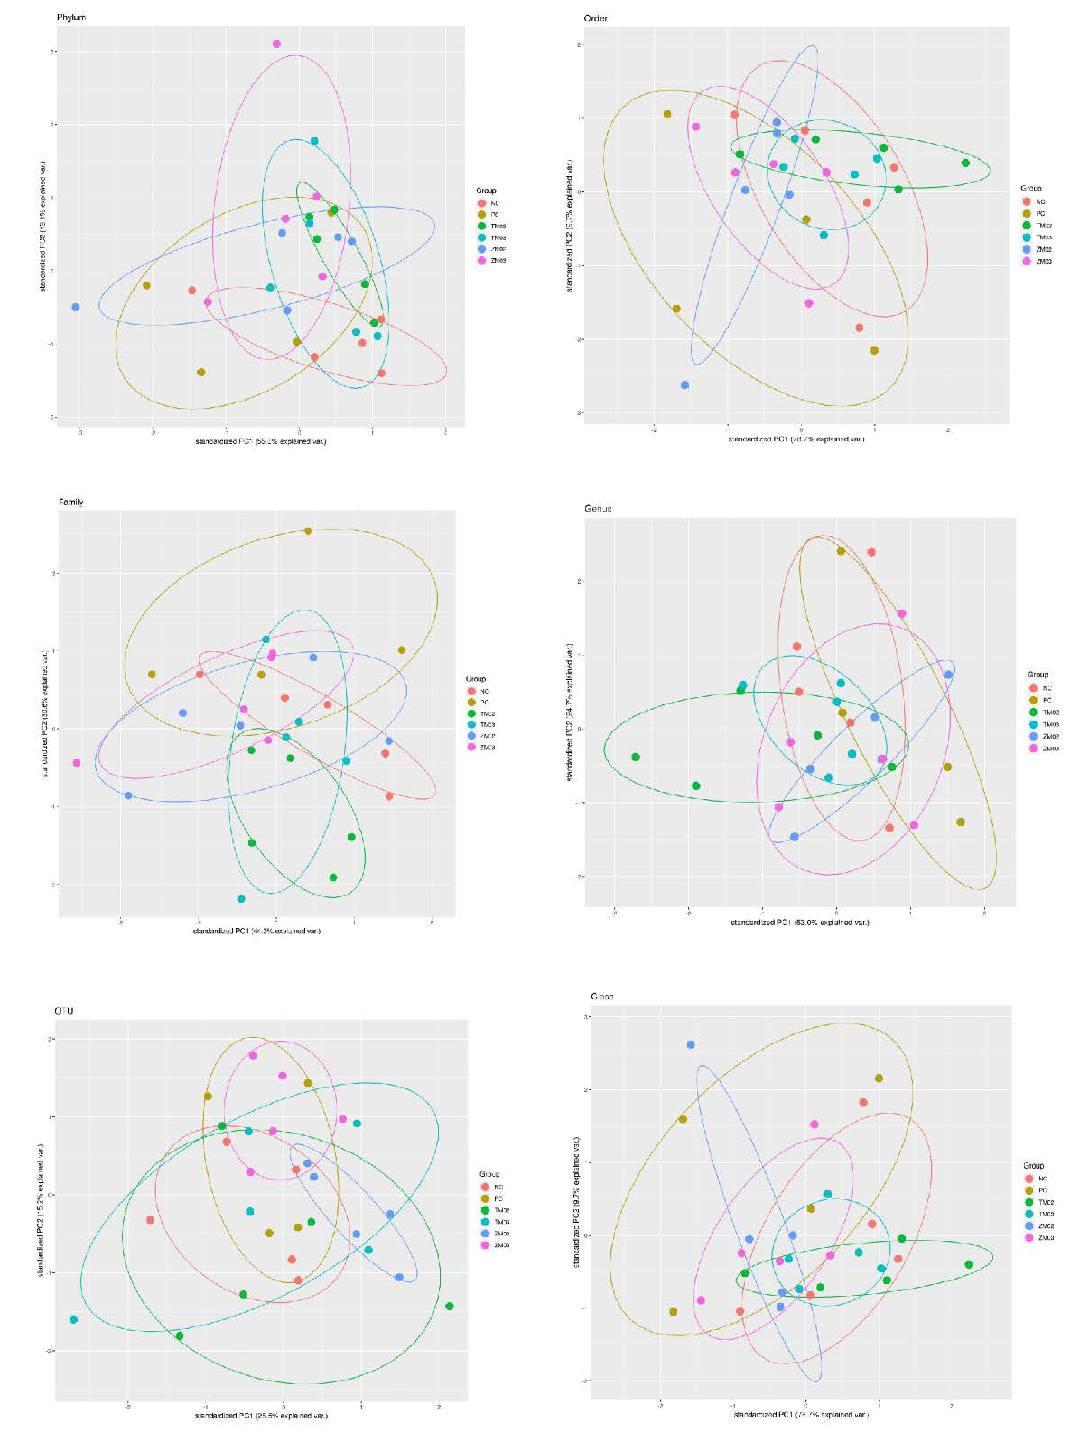
Figure 2. Principal component analysis (PCA) of obtained sequence from cecal digesta samples: PC—positive control (salinomycin, 60 ppm); NC—negative control (no additives); TM02—(0.2% T. molitor full-fat meal); ZM02—(0.2% Z. morio full-fat meal); TM03—(0.3% T. molitor full-fat meal); ZM03—(0.3% Z. morio full-fat meal)